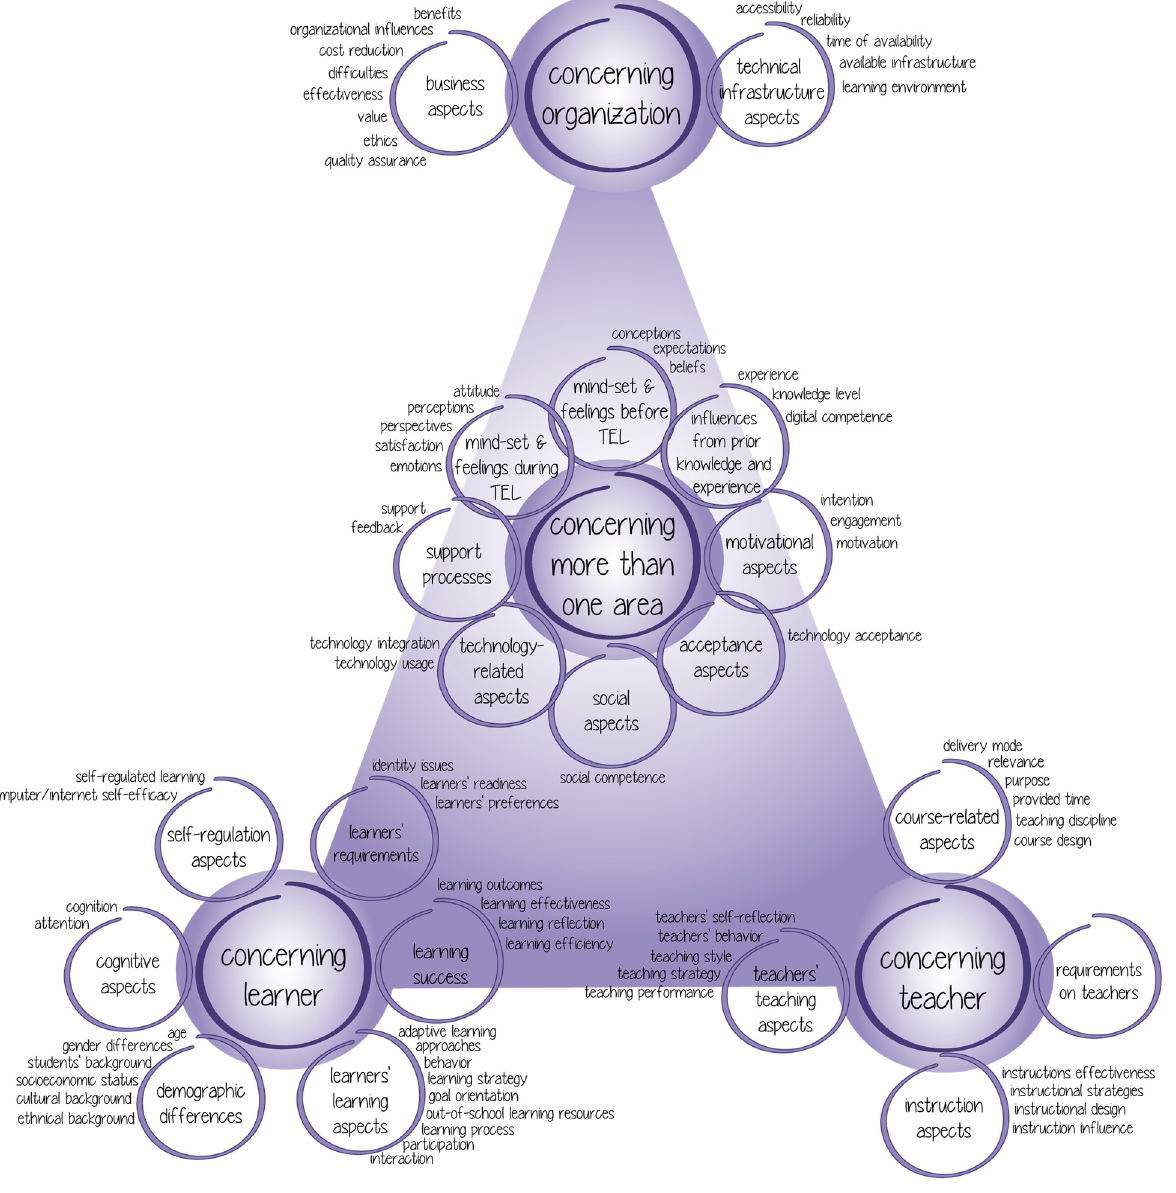
Figure 1. Model of aspects that can be considered when implementing TEL